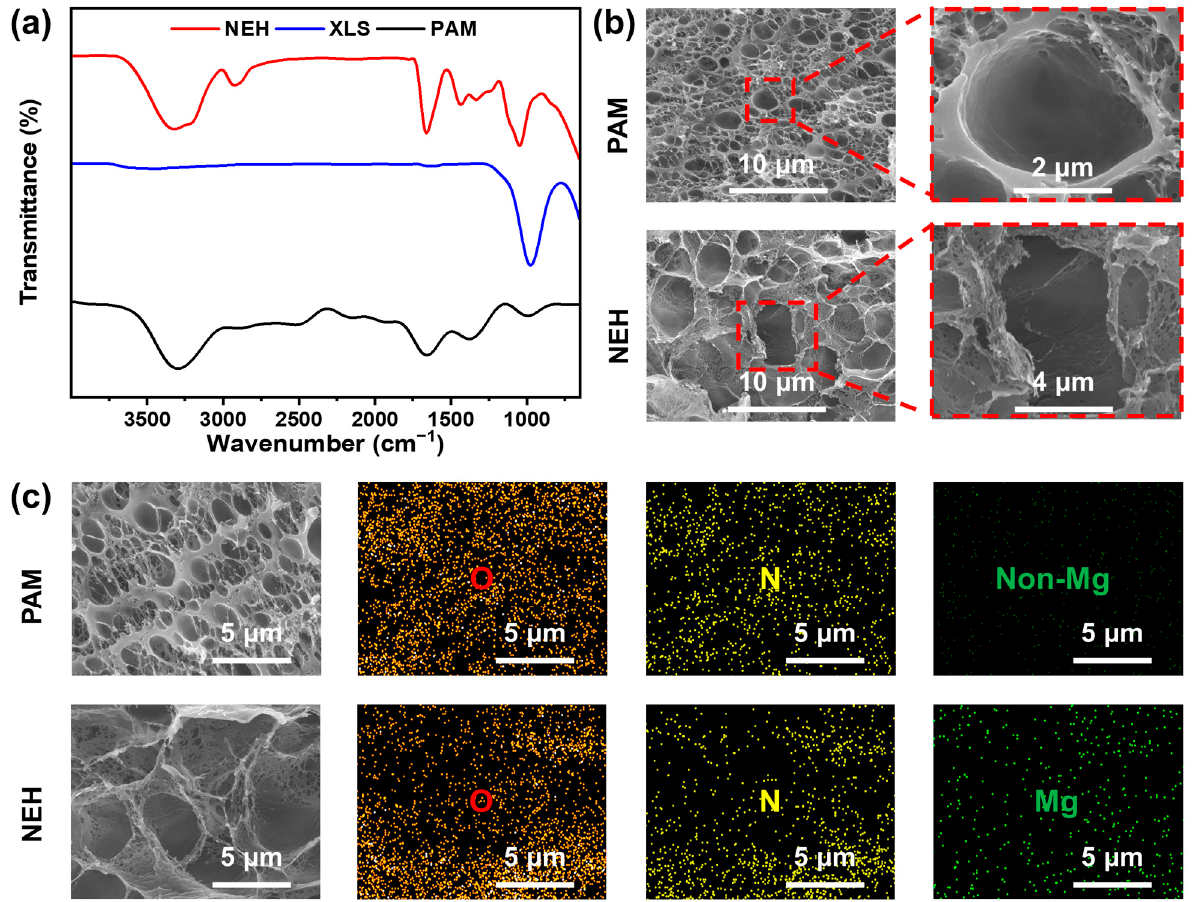
Figure 1. ( a ) FT-IR spectra of NEH, XLS, and PAM. ( b ) SEM and ( c ) EDS mapping of PAM and NEH.